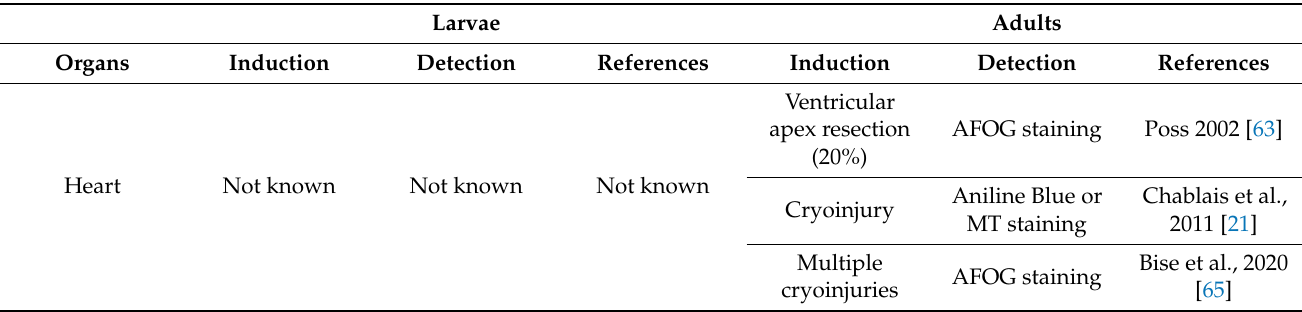
Table 2. Overview of reported zebrafish models of fibrotic disease, differentiating the larval and adult stage, and techniques used for induction and